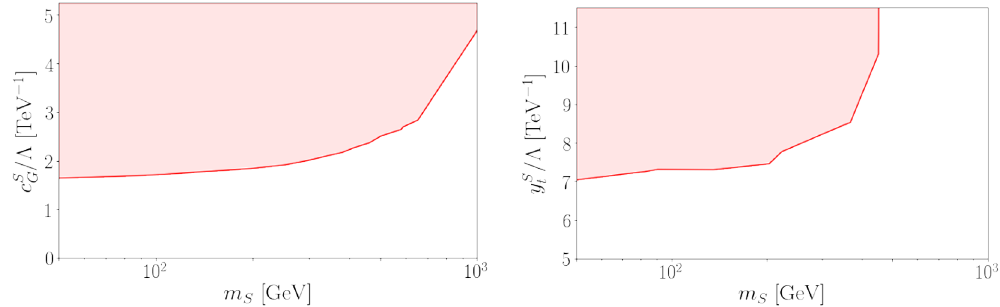
Figure 1 . Exclusion limits from the ATLAS mono-jet search [55] in the m S (cid:0) c S m S (cid:0) y S plane (right), normalized to (cid:3). In both cases y S = 1, m (cid:31) = 10 GeV, and all other couplings t are equal to